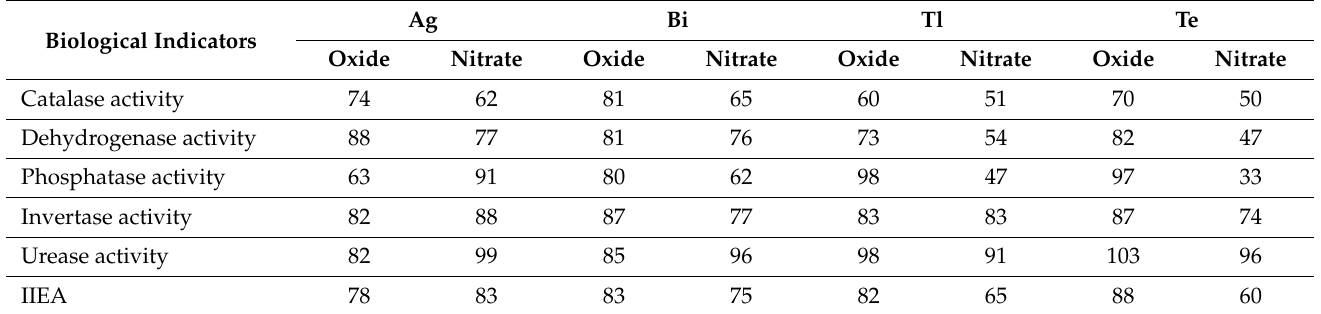
Table 3. The degree of reduction of biological indicators in terms of sensitivity to pollution Ag, Bi, Tl, and Te, % of the